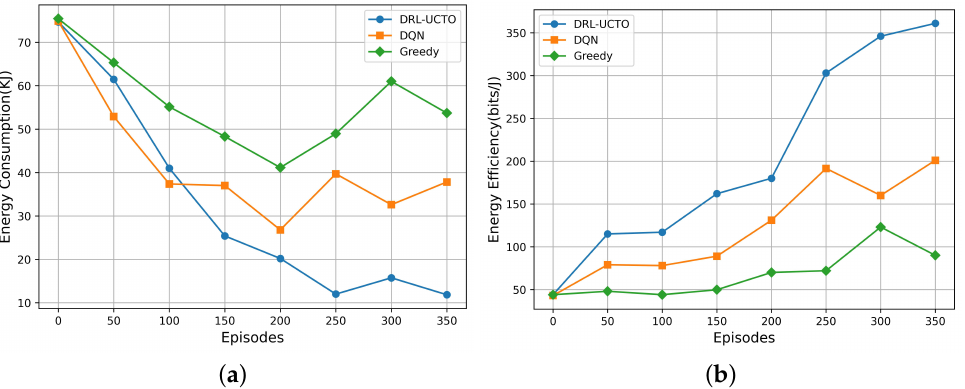
Figure 5. Impact of different algorithms on system energy indicators. ( a ) System energy consumption versus training episodes. ( b ) System energy efficiency versus training